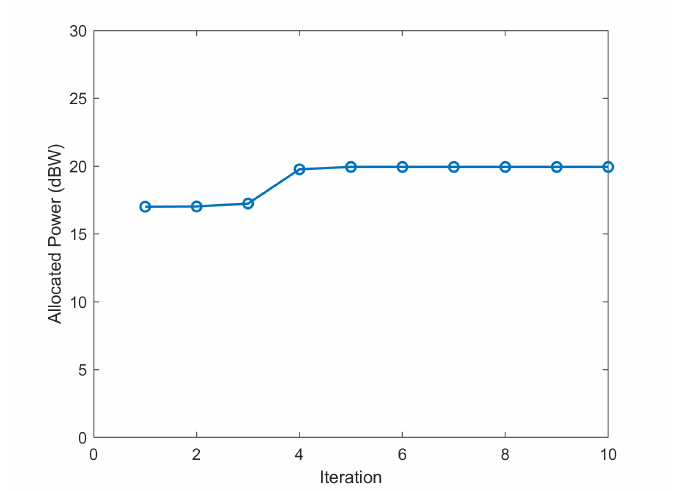
Figure 1. Convergence of the proposed power allocation